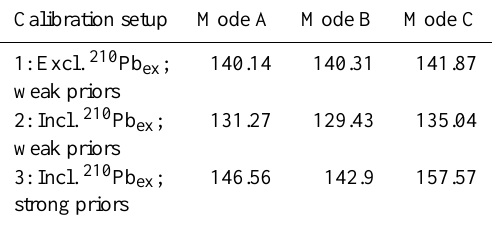
Table 3. Minimum misfit value (see Eq. 11) in the posterior sample for each of the modes for Hainich for the three calibration setups. Note that the misfit values of calibration setup 2 are lower than those of calibration setup 1. This is caused by the fact that the misfit values for the 210 Pbex are negative due to the small number of data points (cf. Eq. 10).